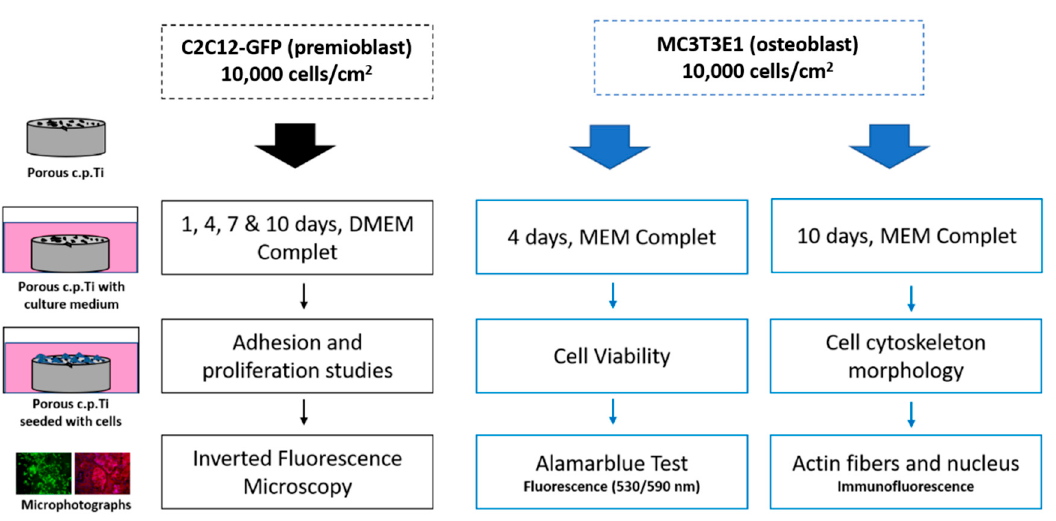
Figure 2. Analytical protocols for the cell studies.